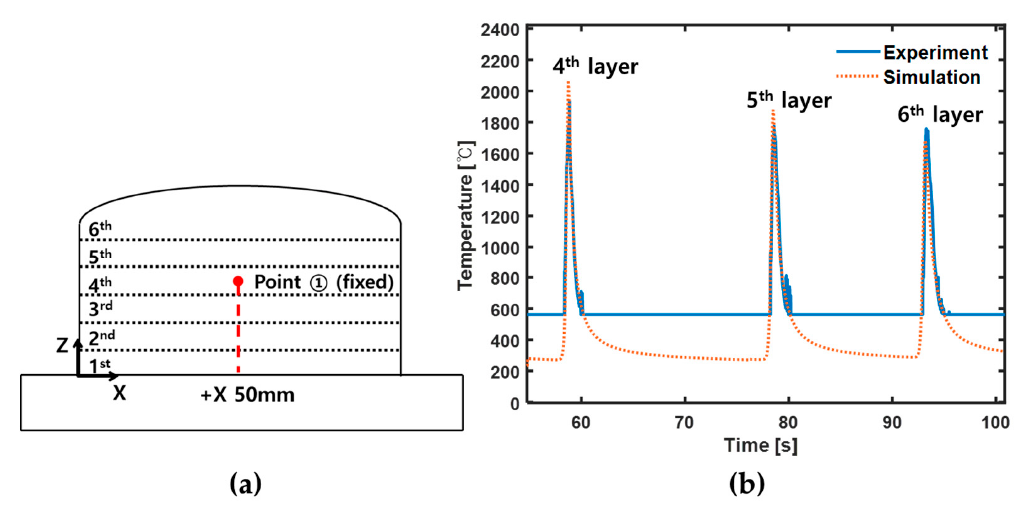
Figure 3. Temperature measurement position and results; ( a ) Schematic diagram of temperature measurement position; ( b ) comparison of simulated and experimental results for temperature profile of deposits.